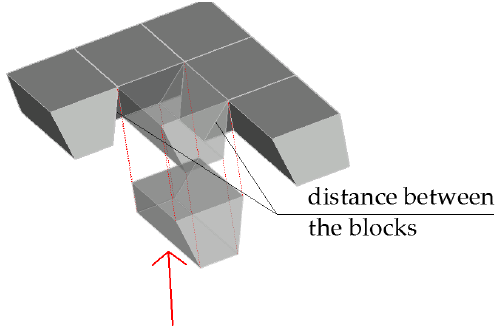
Figure 25. Sliding the components into place in a one-side smooth vault.